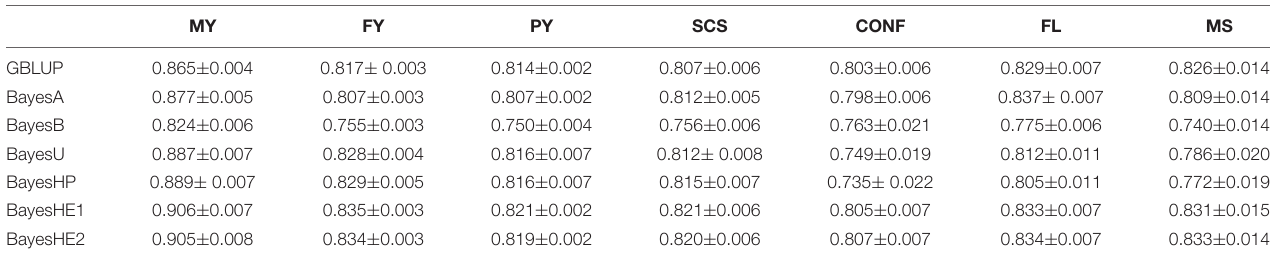
TABLE 3 | Prediction biases of seven traits of dairy cattle data using six-fold cross-validation with five replications. MY FY PY SCS CONF FL